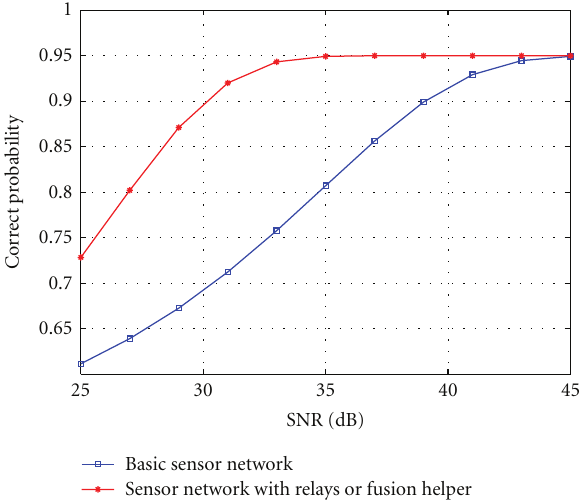
Figure 8: Theoretical correct probability of the overall decision in di ff erent sensor networks under the 2-bit combining rule in Gaussian channels ( A = 0 . 95, β = 3 . 5, d =